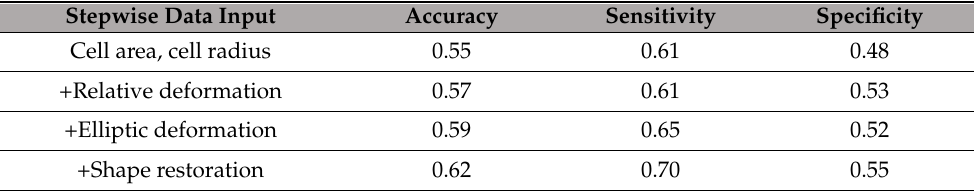
Table 3. Progressive input of parameters of pooled data. To distinguish morphological from mechan- ical effects, we first tested the prediction power of the morphological parameters cell area and cell radius only, and then progressively added the mechanical features relative deformation, elliptical deformation, and shape restoration. The prediction results were computed for the pooled data and revealed superior accuracy, sensitivity and specificity when specific mechanical parameters were included. The values at the last step do not match the corresponding values in Table 2, since here we added only the first three most important mechanical parameters and the prediction in Table 2 contained numerous additional